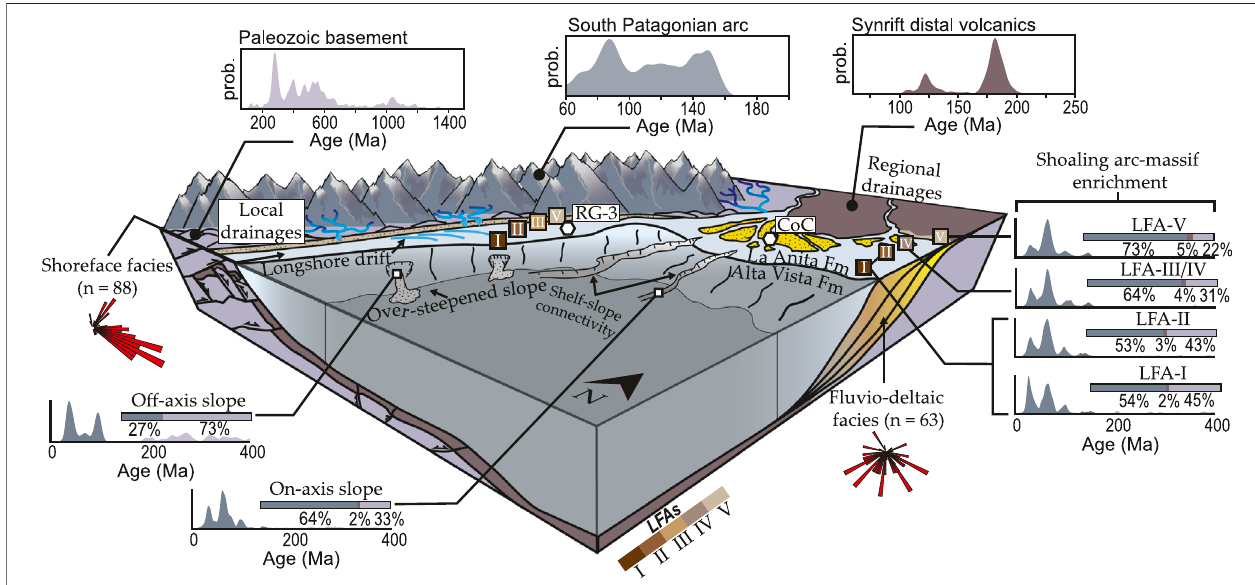
FIGURE 12 | Schematic depositional model for the Alta Vista and La Anita Formations and explanation for noted variation in detrital zircon age distributions in concert with change in depositional environments. Colored squares with labeled roman numerals are approximate locations of interpreted depositional environments fromlithofaciesassociations.Whitehexagonsareexamplesofapproximatelocationsofmeasuredstratigraphicsectionsfromthisstudy.Sourceregionsarecolor-coded and labeled as deriving from either the Patagonian arc, Jurassic synrift volcanic materials from regional terranes, or Paleozoic basement uplifted along the Cretaceous orogenic front. Note that samples closer to the La Anita delta (in yellow) and shoreface (in tan) are able to more easily sequester sediment from regionally developed catchments tapping both the magmatic arc and distal sources. Moving down-section, the local fold-and-thrust belt signature becomes more pronounced, and distal sources diminish (see age distributions of LFA-1 and LFA-2 compared to LFA-3/4 and LFA-5). Paleocurrents from shoreface facies suggest that progressive longshoredrift andshallow-marine transportprocessesmay havebeen abletoadequately moveenough locallyderivedsedimenttosubstantiallydilutethe fl uvio-deltaic signature. For the Alta Vista Formation, note the markedly different age distributions between the on-axis and off-axis samples. Those from on-axis strata, rich in thick- bedded highdensity turbidites,were likelydirectly connected totheLaAnita delta, whichresultedinsimilaragedistributions. Conversely, thoseportions oftheAlta Vista Formation with no evidence of high rates of sedimentation may have been wholly isolated from the La Anita delta and thus only capable of transporting predominantly local